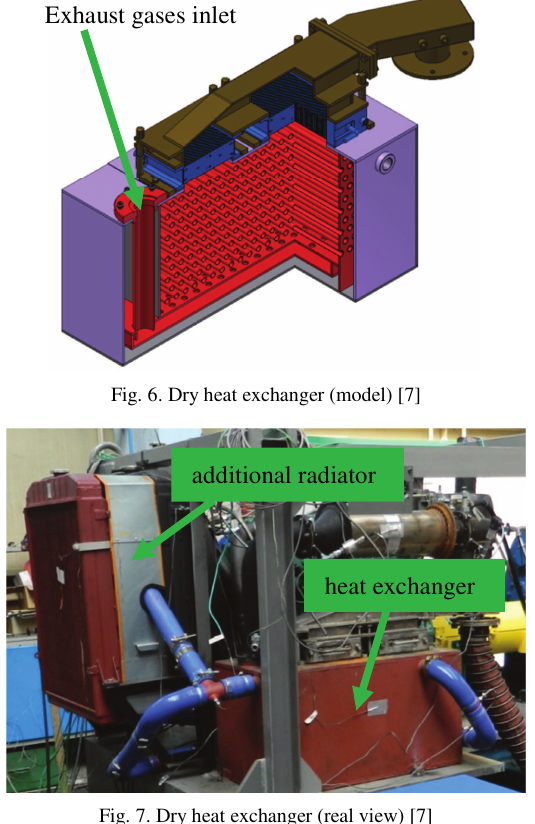
Fig. 7. Dry heat exchanger (real view) [7]